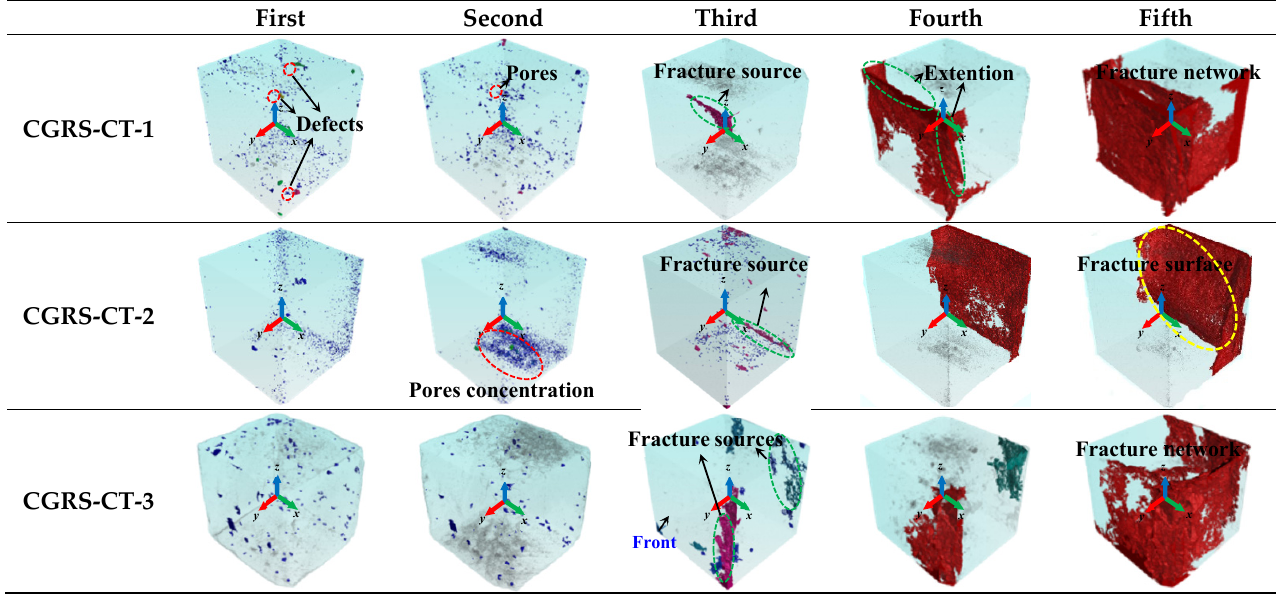
Figure 6. Three-dimensional crack spatial distribution of samples in different stages of the fracturing process. Horizontal graphs represent the same specimen in 3D at different scanning stages. The morphological distribution of cracks from sprouting to final rupture after loading of the specimens was recorded in detail.